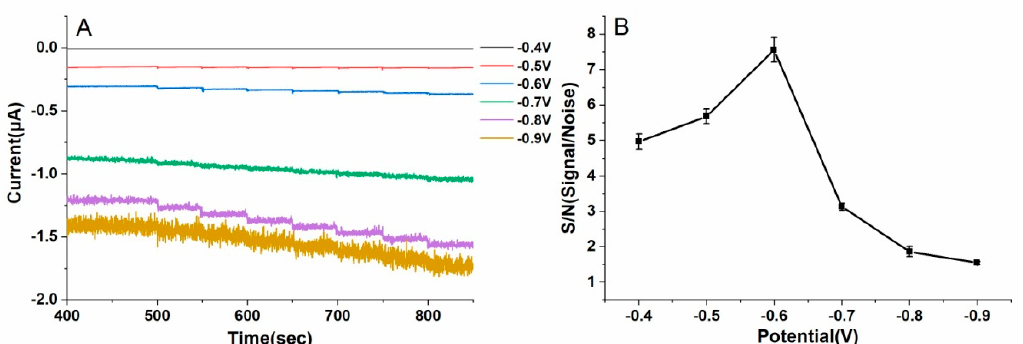
Figure 3. ( A ) The amperometric response of Au/SS wire-based electrochemical microsensor to continuous additions 10 µLH 2 O 2 with concentration 100 mMin 10 mL solution with 0.2 M PBS (pH 7) at different application potentials. ( B ) The relationship between S/N ratio and applied potential ( n = 7).